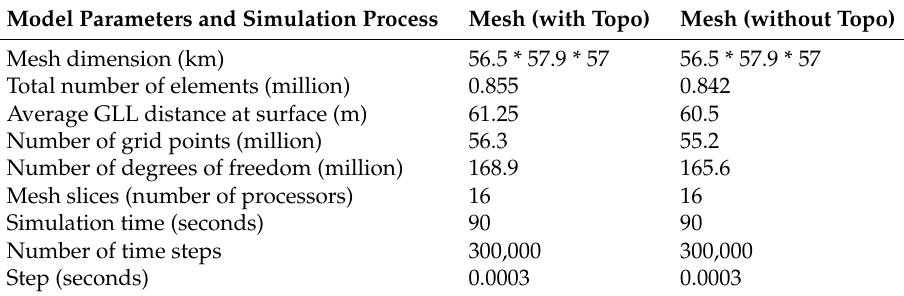
Table 1. Mesh properties and simulation